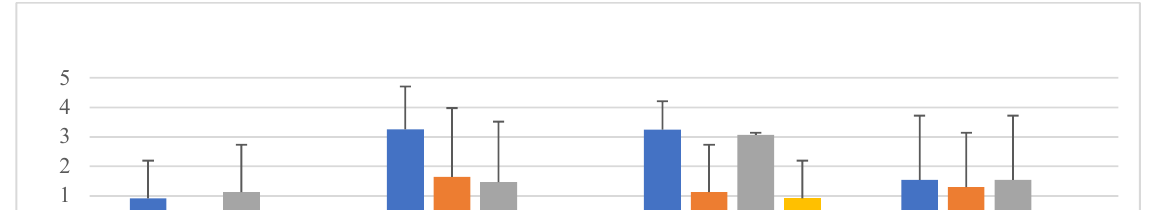
Figure 4. Mean population of aerobic mesophilic bacteria (pre- and post-treatment) for free-range shell eggs and com- mercial farm shell eggs.